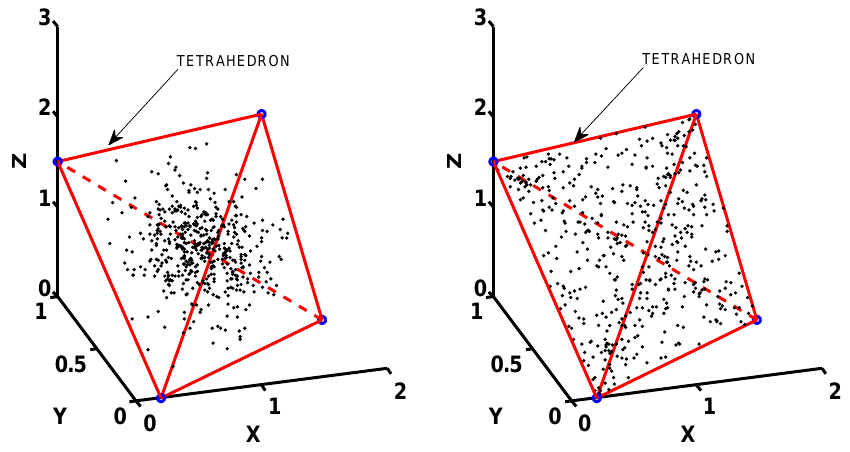
Figure 4. On sampling initial conditions in a convex polytope in (cid:60) 3 with vertices A = (1 . 8 , 0 . 5 , 0) , B = (1 , 0 , 3) , C = (0 , 1 , 1 . 5) and D = (0 . 2 , 0 , 0) . ( Left ) Five hundred points are generated by Equation (10) with uniformly random values 0 ≤ ˜ w (cid:80) 4 = ˜ w / ˜ w and ¯ w ; notice the poor sampling close to the boundaries; ( Right ) Five i i j j =1 hundred points are generated by Equation (10) with uniformly random values 0 ≤ z (cid:80) 4 ˜ w = [ − ln ( z )] 1 . 5 ( i.e. , p = 1 . 5 ) and ¯ w = ˜ w / ˜ w . The latter approach generates a i i i i j j =1 more uniform sampling of the polytope